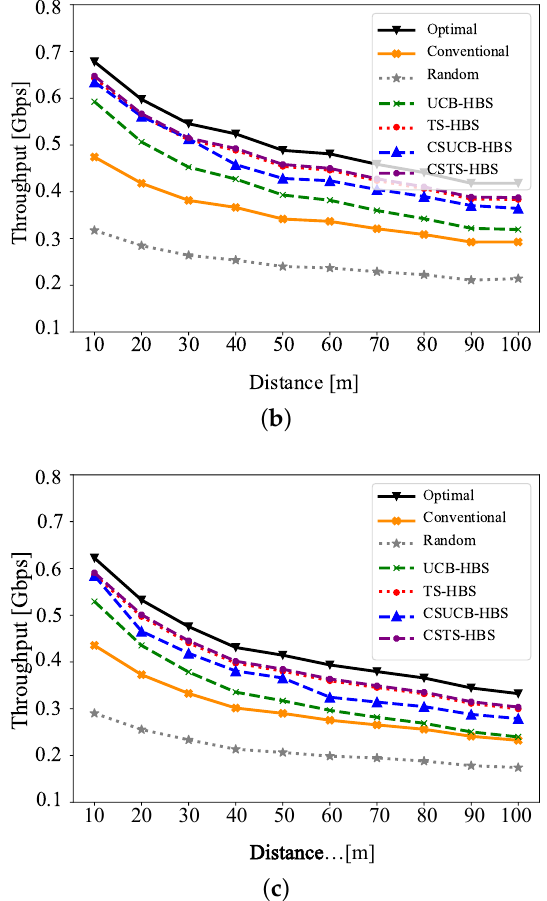
Figure 3. Average throughput comparison of CSTS/CSUCB-HBS approaches vs. separation distances at distinct blocking layouts. ( a ) No blockage. ( b ) Small blockage. ( c ) Large